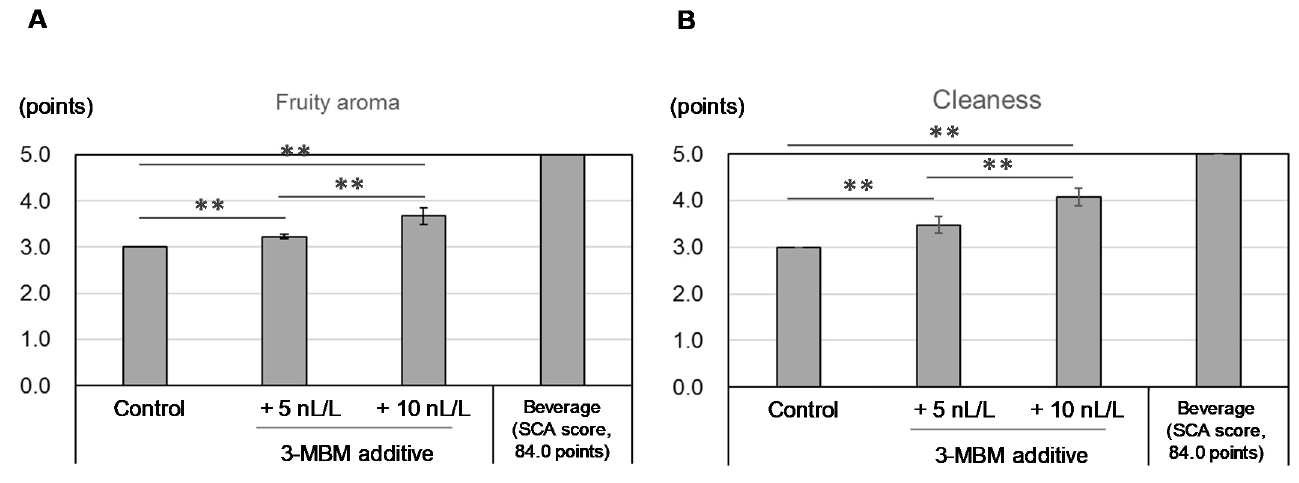
Figure 3. Sensory evaluation of coffee brews without and with added 3-MBM (5 nL/L or 10 nL/L). ( A ) Fresh-fruity aroma and ( B ) cleanness were evaluated by four trained panelists. Statistical significance is indicated by the Student t test (** p < 0.01).